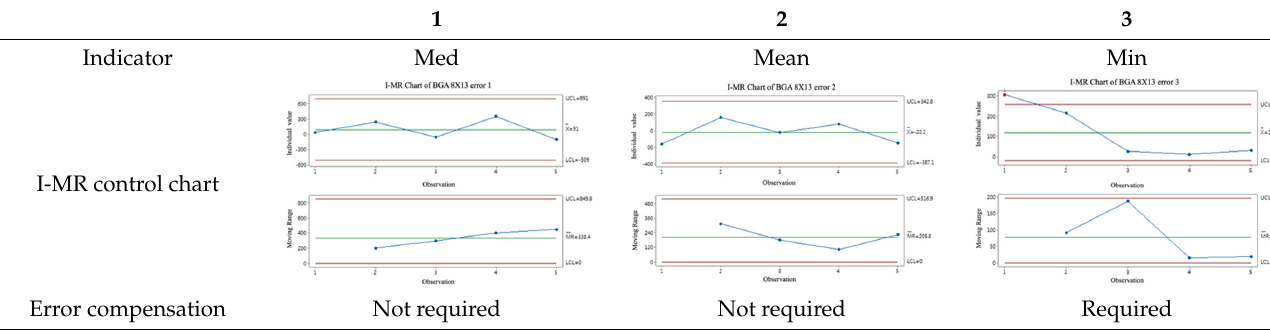
Table 6. BGA 8X13 three rolling results.